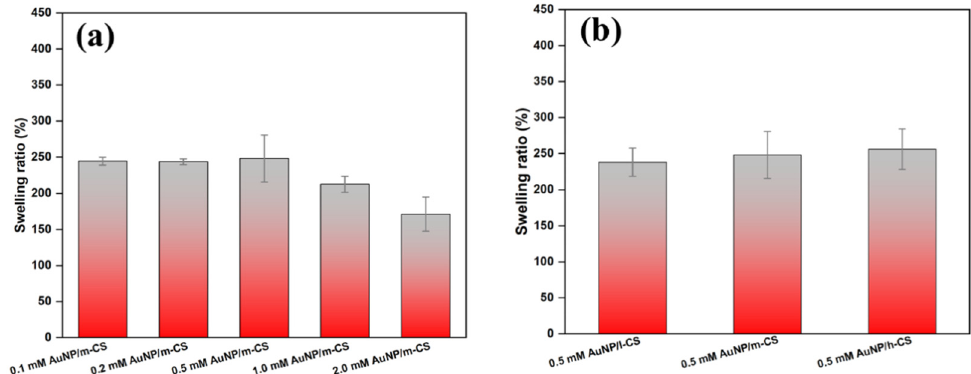
Figure 6. Swelling ration of typical Au/CS composite film samples in PBS. ( a ) Swelling ration of 0.1 mM AuNP/m-CS, 0.2 mM AuNP/m-CS, 0.5 mM AuNP/m-CS, 1.0 mM AuNP/m-CS, and 2.0 mM AuNP/m-CS films. ( b ) Swelling ration of the 0.5 mM AuNP/l-CS, 0.5 mM AuNP/m-CS, and 0.5 mM AuNP/h-CS films.